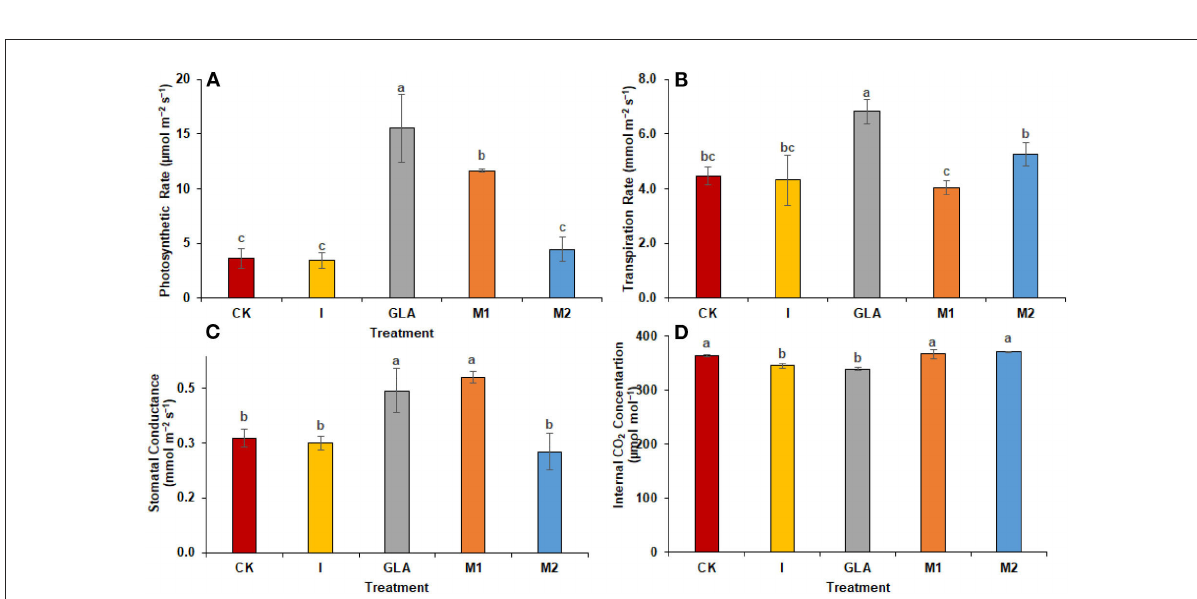
FIGURE9 Gaseous exchange parameters: (A) Photosynthetic rate, (B) Transpiration rate, (C) Stomatal conductance (D) Internal CO 2 concentration observed in experiment 2 using chemical fertilizer (CK), Isabion ® (I), glycine + lysine + aspartic acid (GLA), moringa leaf extract + GLA (M1), 25% NPK + M1 (M2). The values mentioned herein are indicated as mean ± S.D and the lowercase letters indicate the significant difference among the